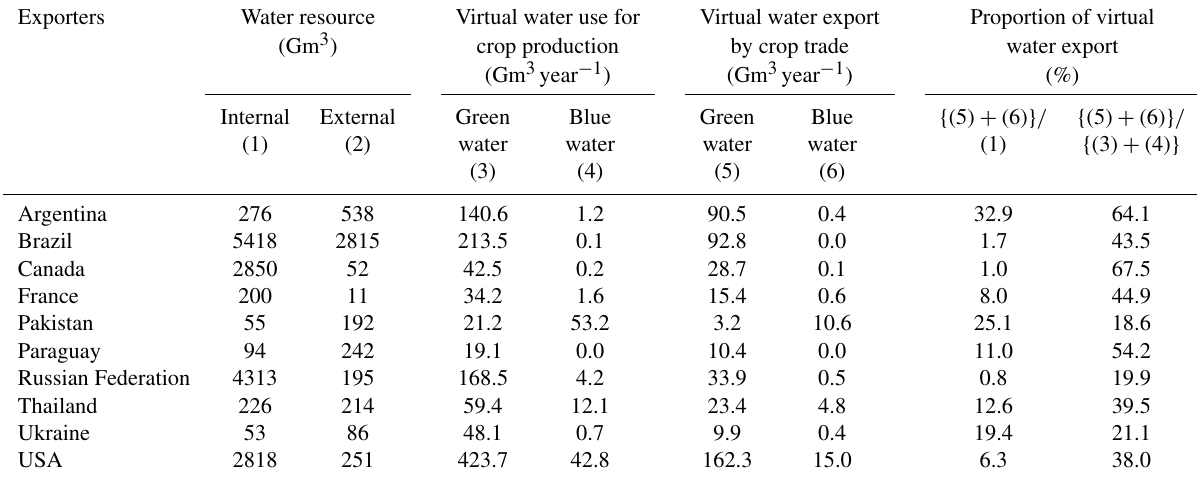
Table 7. Water resource and virtual water use for production and exporting